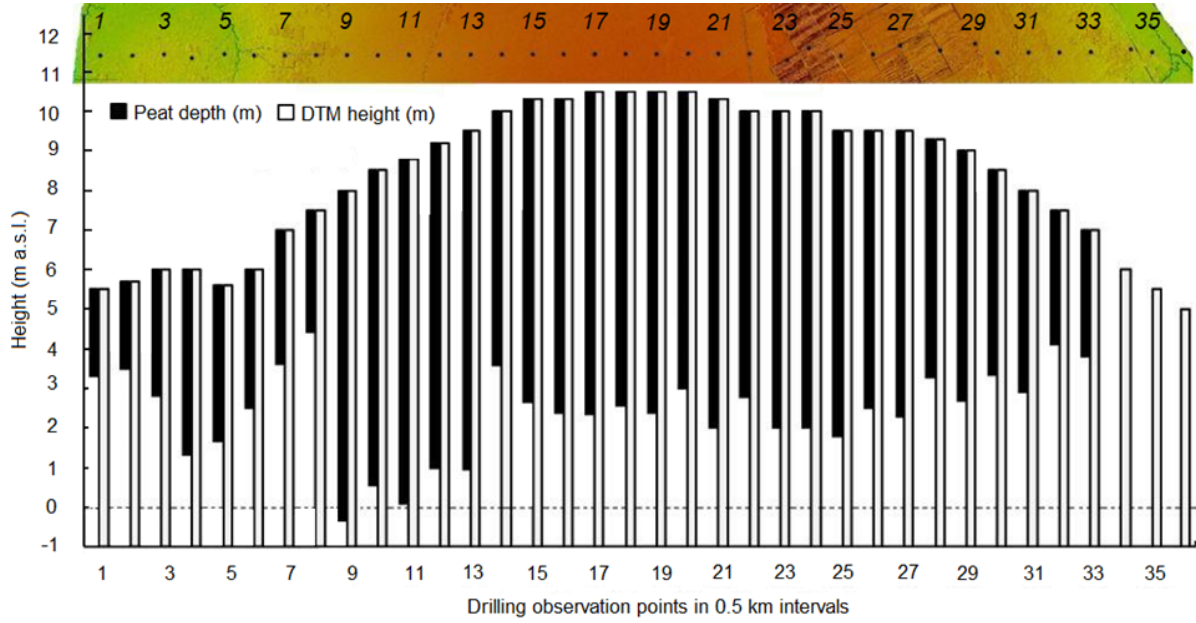
Figure 6. Longitudinal section from north (left-hand side of diagram) to south along Transect CS2. Above the profile, the plan locations and numbering of survey points are superposed on a strip of the DTM shown in Figure